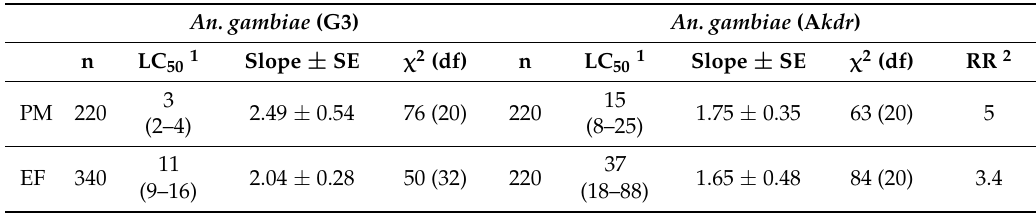
Table 1. First-instar toxicity of permethrin (PM) and etofenprox (EF). An. gambiae (G3) An. gambiae (A kdr